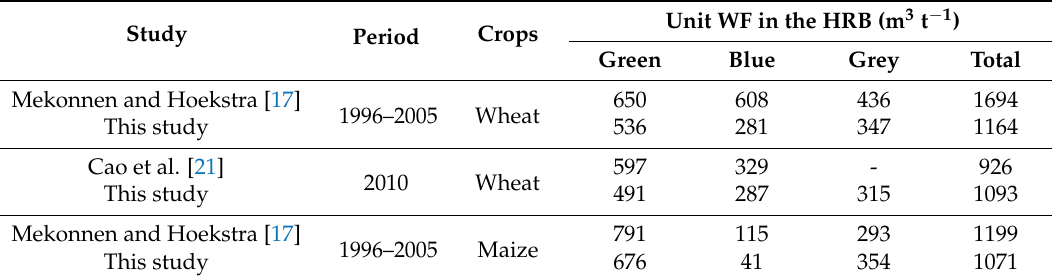
Table 7. The comparison of unit WF with other studies in the